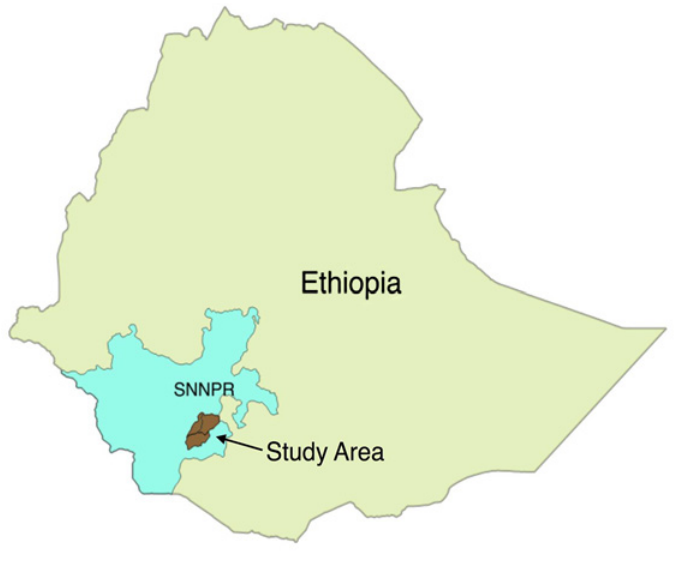
Fig 1. The map of the study area within southern